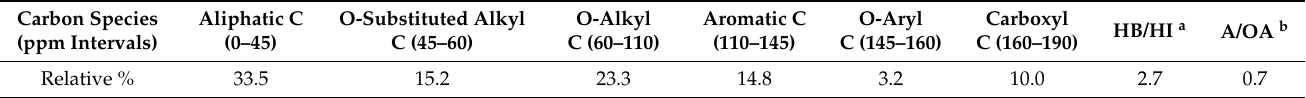
Table 1. Relative carbon percent distribution over different chemical shift (ppm) intervals of the cross-polarization magic- angle spinning–nuclear magnetic resonance (CPMAS-NMR) spectrum of the compost and the corresponding indexes. Carbon Species (ppm